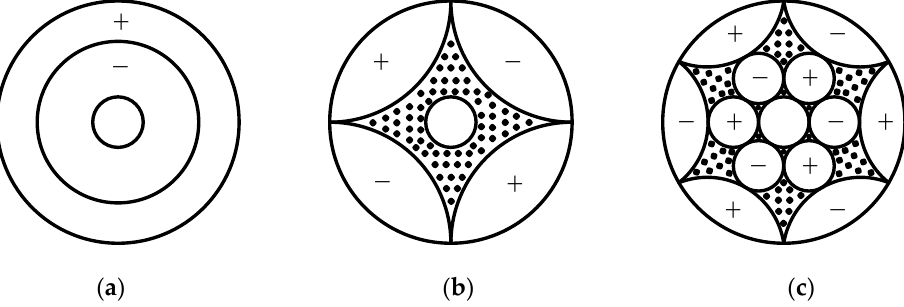
Figure 2. Vibration modes of disc structure: ( a ) 1st NC; ( b ) 2nd ND; ( c ) 1st NC and 3rd ND.